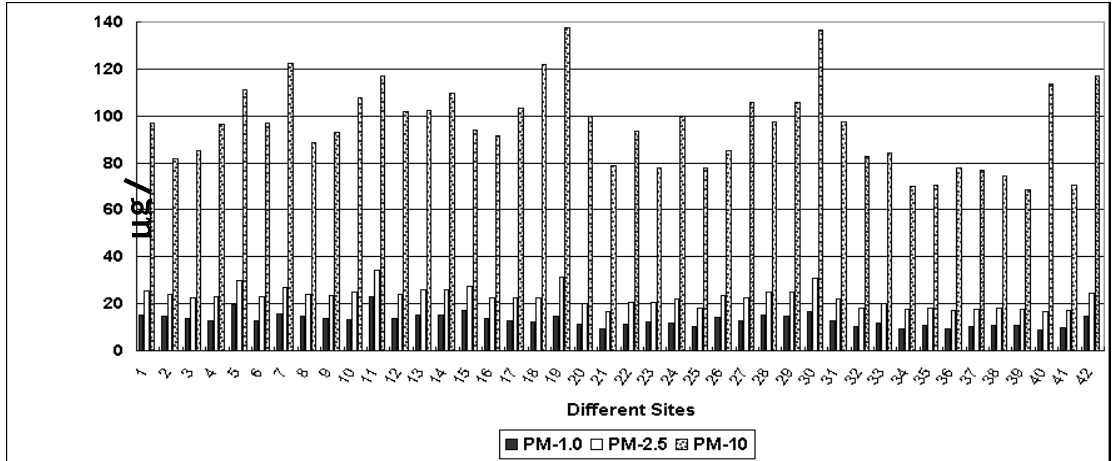
Figure 2. Mean concentrations of particulate matter in the warm season